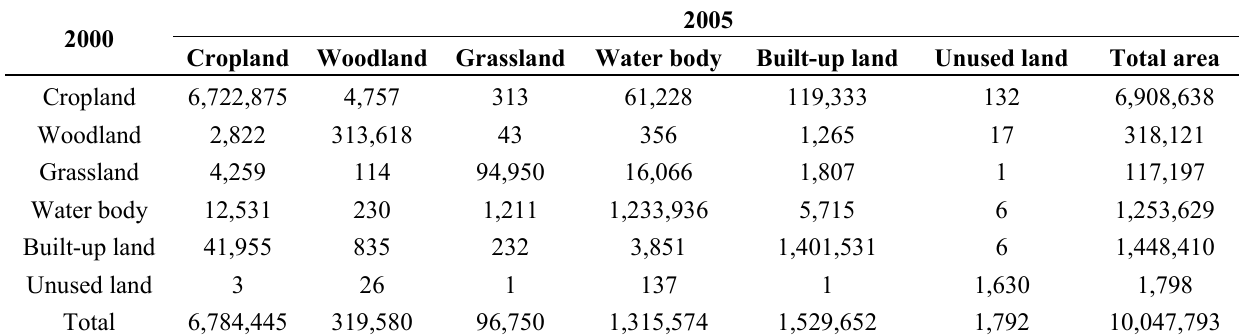
Table 2. Conversion matrix of land use from 2000 to 2005 (unit: